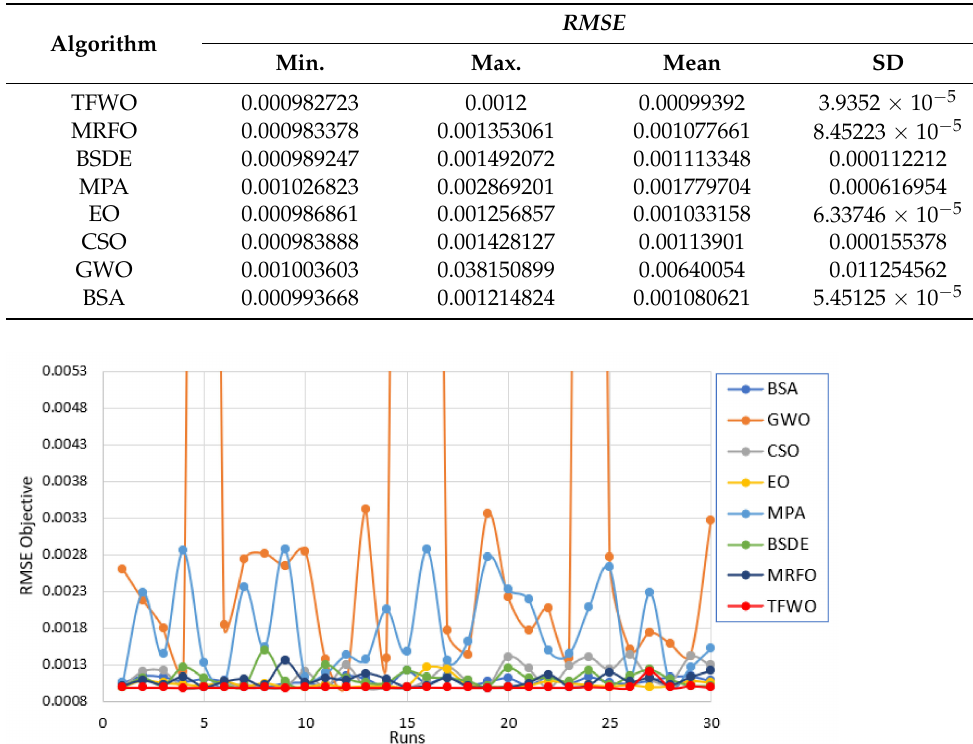
Table 6. Statistical analysis of RMSE for R.T.C. France DDM.